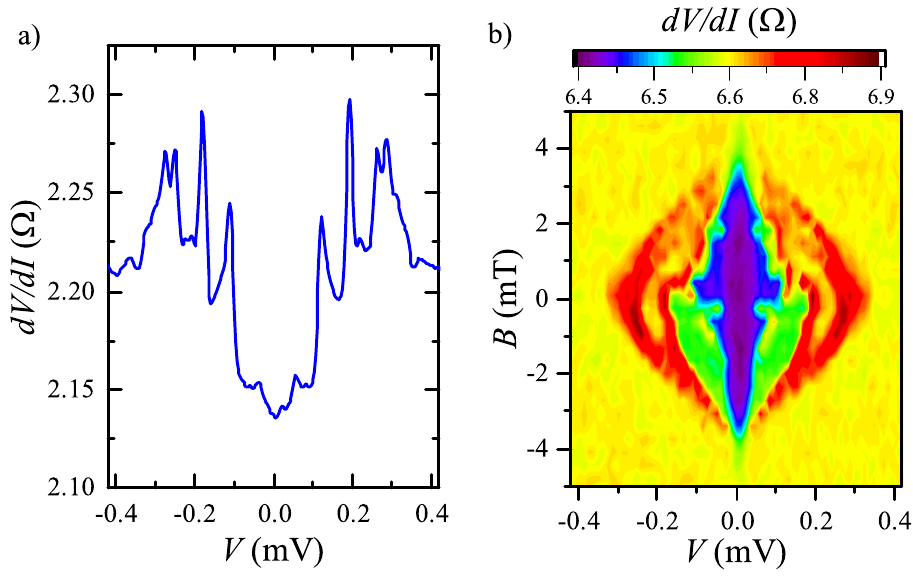
Figure 4. (Color online) ( a ) Non-Ohmic behavior of dV / dI ( V ) for a different sample to show typical sample-to-sample variation. The behavior is qualitatively the same as for the first junction in Figure 2. ( b ) The suppression of dV / dI ( V ) curves in normal magnetic field. Some dV / dI ( V , B ) asymmetry can also be seen for this sample. The data are obtained at 30 mK